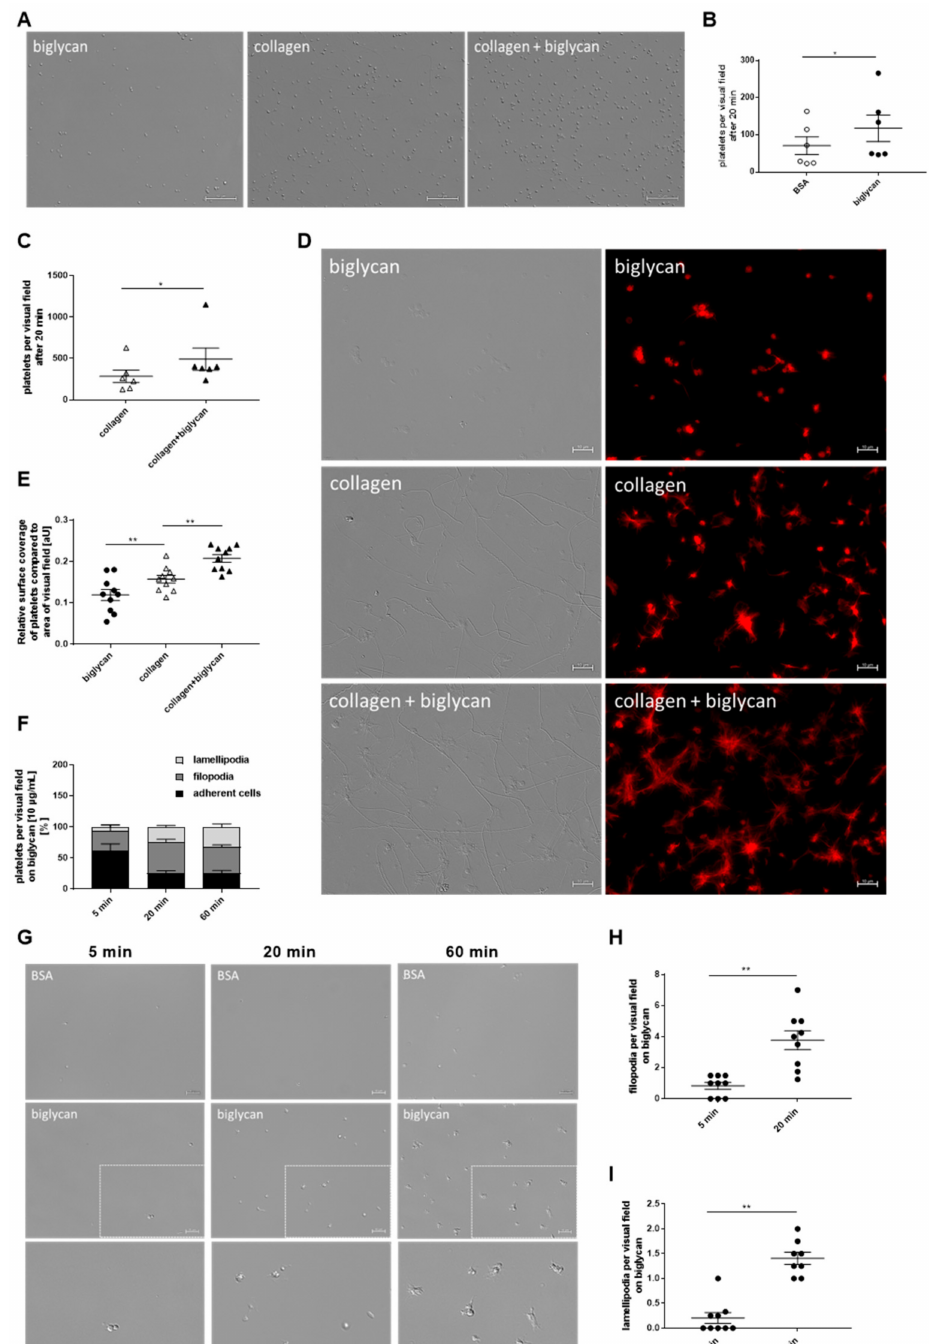
Figure 3. Adhesion and spreading of human platelets on immobilized biglycan. ( A – C ) Adhesion of human platelets on immobilized biglycan, collagen, and biglycan-collagen. ( A ) Representative images show adherent platelets on a recombinant biglycan (10 µ g/mL), collagen (200 µ g/mL), and biglycan-collagen (10/200 µ g/mL) matrix, scale bar = 50 µ m. ( B ) Enhanced adhesion of human platelets on immobilized biglycan (10 µ g/mL) compared to BSA (10 mg/mL) control matrix after 20 min, n = 6, mean values ± SEM. Statistical analysis was performed with two-tailed, paired Student’s t -test. ( C ) Enhanced adhesion of human platelets on a biglycan-collagen (10/200 µ g/mL) matrix compared to collagen (200 mg/mL) after 20 min, n = 6, mean values ± SEM. Statistical analysis was performed with two-tailed Wilcoxon matched-pairs signed-rank test. ( D ) F-actin staining of human platelets that were allowed to spread on biglycan (10 µ g/mL), collagen (200 µ g/mL)